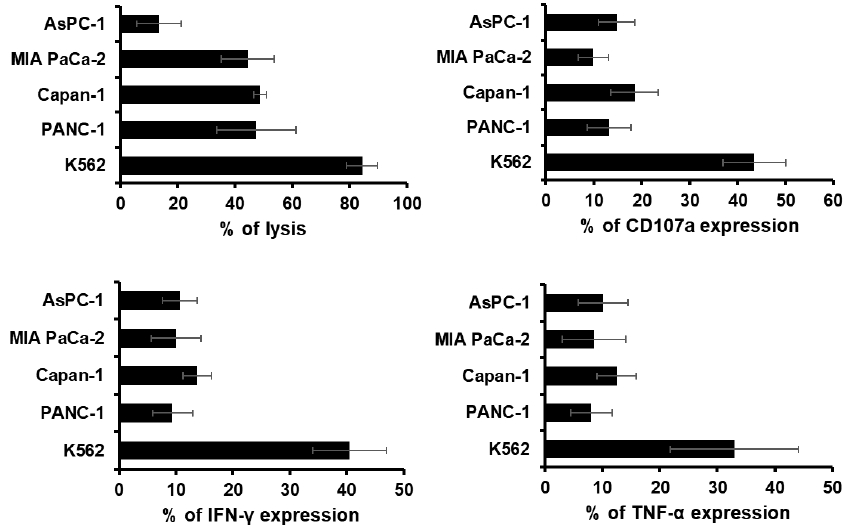
Figure 2. Cytotoxic e ff ect of cryopreserved natural killer (NK) cells following co-culture with cancer cells. Direct cytolytic activity of NK cells was assessed by calcein-acetoxymethyl (AM) release assay using K562 and various pancreatic cell lines (AsPC-1, MIA PaCa-2, Capan-1, and PANC-1) at an e ff ector-to-target (E:T) ratio of 10:1. The levels of degranulation marker cluster of di ff erentiation (CD)107a and cytokine (interferon (IFN)- γ and tumor necrosis factor (TNF)- α ) expression on NK cells were assessed by flow cytometry following co-incubation of K562 or pancreatic cancer cells with NK cells at an E:T ratio of 1:1. Data are representative of three independent experiments. Results show the mean percentages ± standard deviation (SD) of reactive NK cells within each NK subset (n =